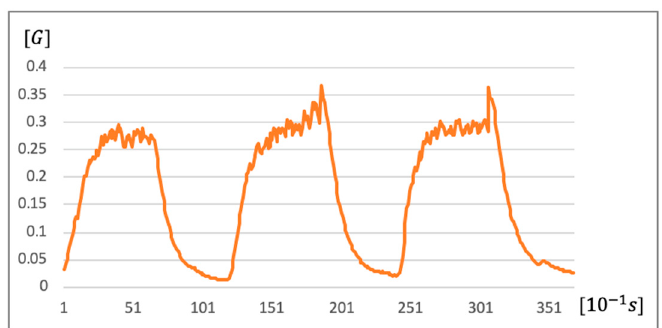
Figure 9. Example of changes in acceleration values with a low-pass filter (a tester repeated ten walking steps and then stopped for five seconds three times. This test suggested that Th 2 can be set to around 0.15 [G].)